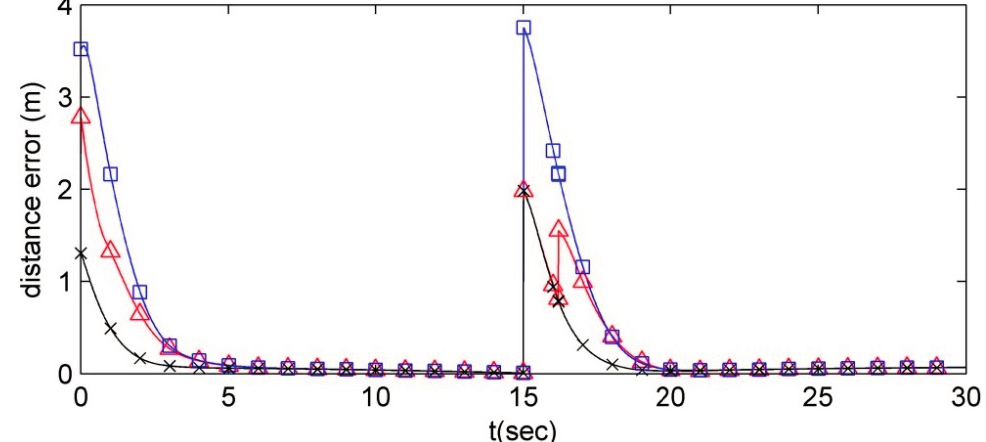
Figure 10. The formation distance errors of three position allocation algorithms ( □ : fixed-ID matching, ×: optimization, and ∆ : proposed